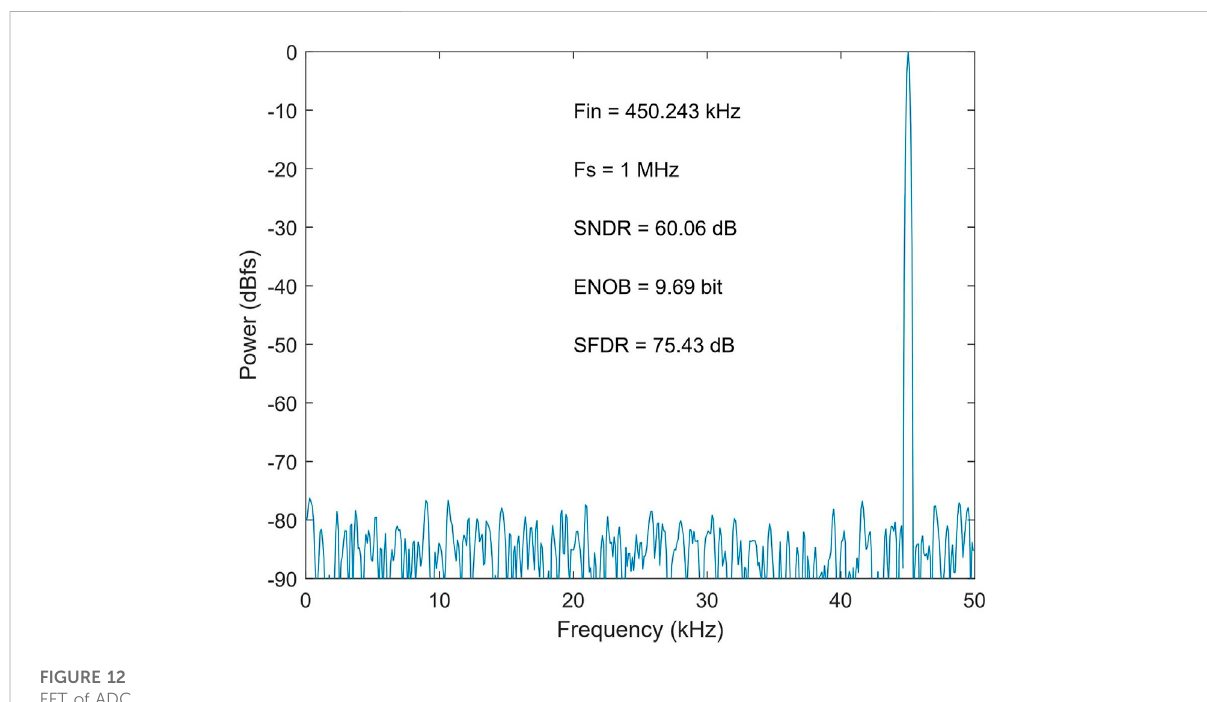
FIGURE 12 FFT of